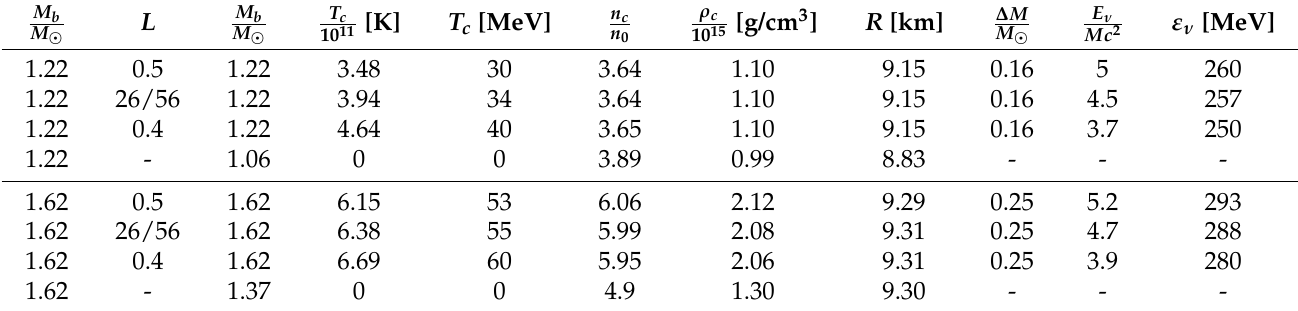
Table 1. Integral parameters of PQS. M b is the baryonic mass, M is the gravitational mass, L is the initial relative lepton charge, T c , ρ c , and n c are, respectively, the temperature, the density, and concentration of the baryonic charge in the center of the star, n 0 = 0.15 fm − 3 is the nuclear saturation density, R is the PQS radius, ∆ M - the decrease in the mass of the PQS with cooling to T → 0, E ν is the energy of neutrino gas, and ε ν is the average neutrino energy. The table also lists the parameters of this star in the cold